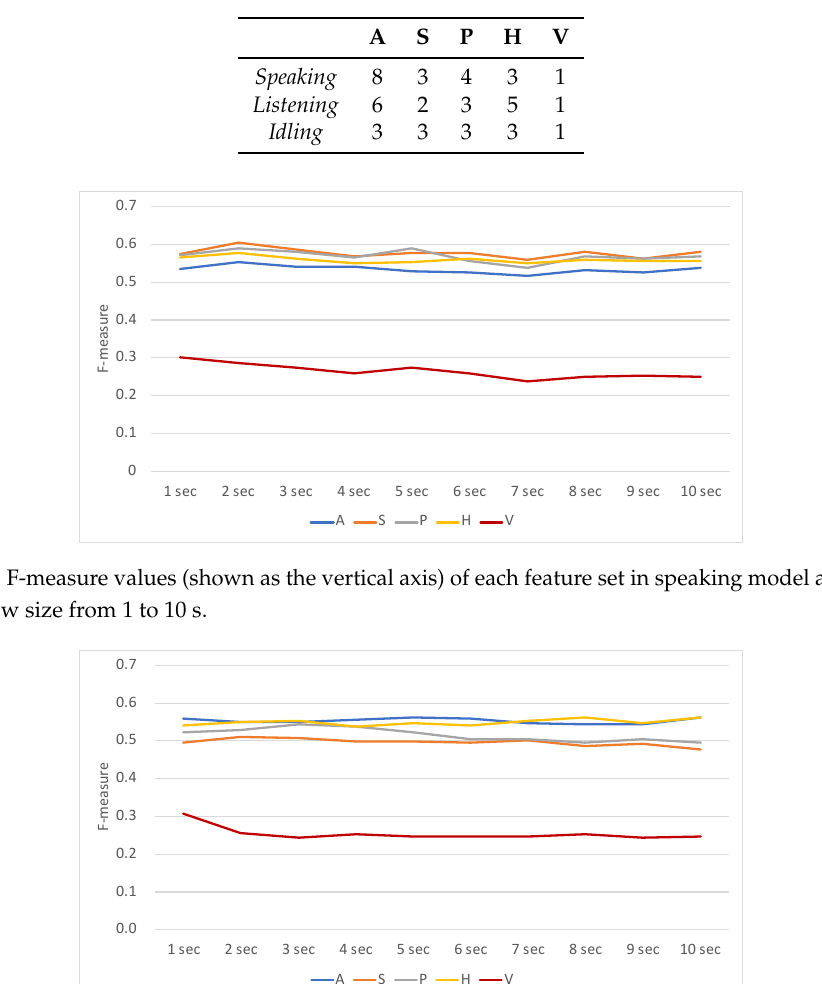
Table 3. Optimal window sizes (in seconds) regarding feature sets and prediction models.